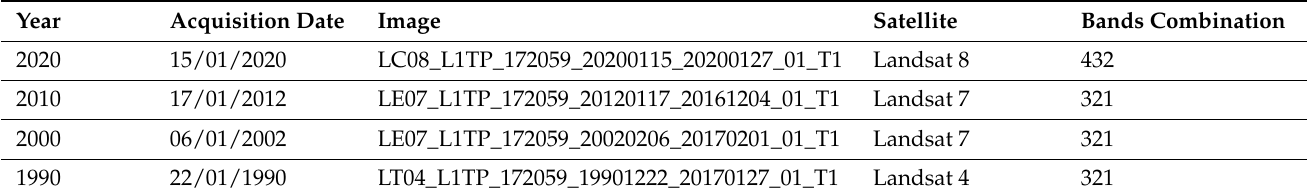
Table A1. Specifications for satellite data of Budongo–Bugoma landscape.